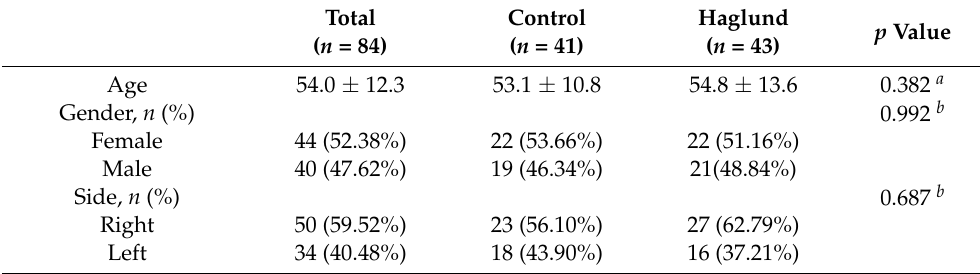
Table 1. Characteristics of the study